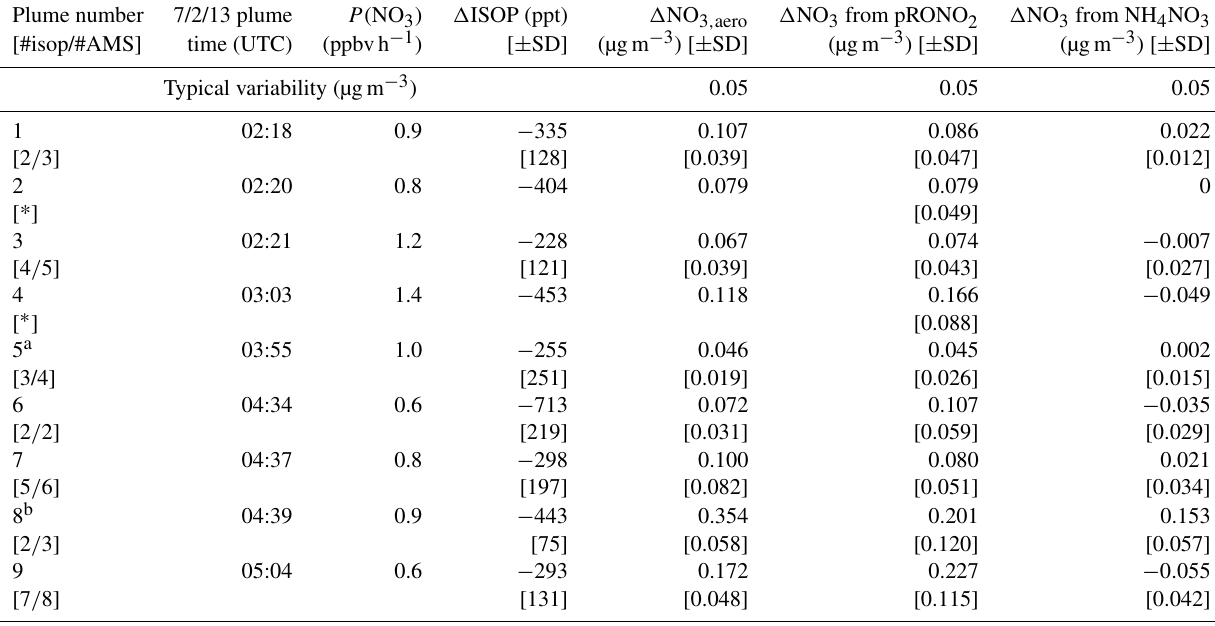
Table 1. List of plumes used in this NO 3 + isoprene SOA yield analysis. For each plume, the delta values listed indicate the difference between in-plume and outside-plume background in average observed concentration, and the standard deviations (SD) are the propagated error from this subtraction. (For (cid:49) NO 3 from pRONO 2 , the standard deviations also include error propagated as described in the caption for Fig. 4) After each plume number, the numbers of points averaged for isoprene (10s resolution) and AMS (10s resolution) are listed, respectively. As the isoprene data were reported at a lower frequency, these numbers are typically lower to cover the same period of time. Plume numbers annotated with ∗ indicate brief plumes for which only single-point measurements of in-plume aerosol composition were possible. Additional AMS and auxiliary data from each plume is included in the Supplement, Table S3.